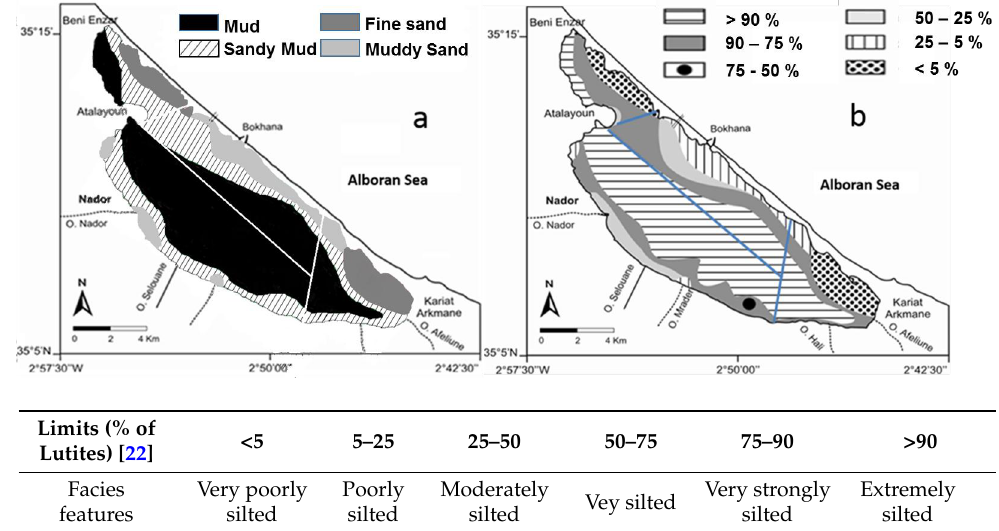
Figure 4. Global distributions of surface sediment facies ( a ) and lutite rates (degree of siltation) ( b ) within the Nador lagoon